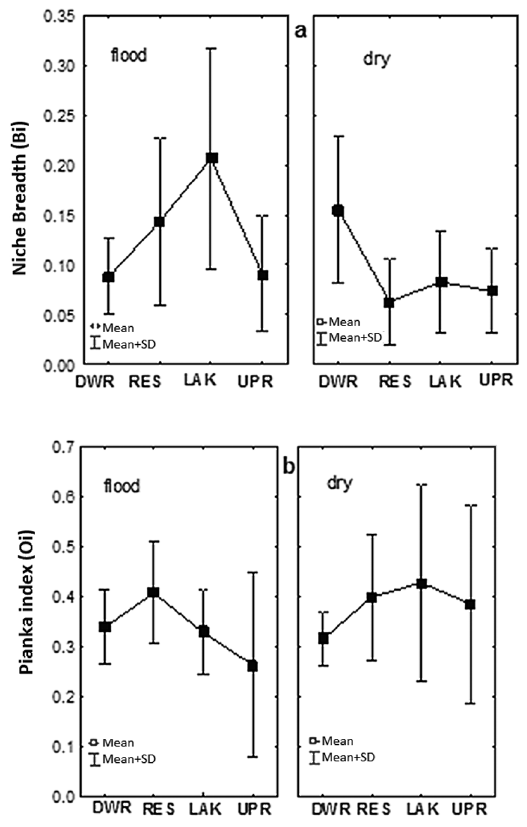
Figure 3 - Fish communities from areas under influence of